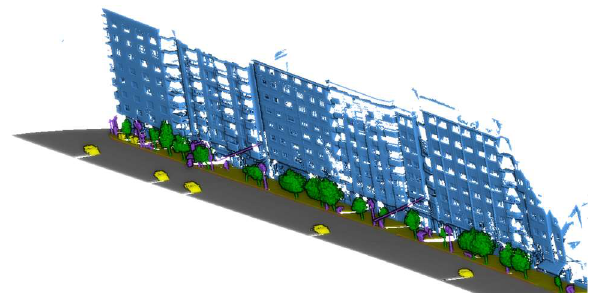
Figure 3: Time signal generated from consecutive scanlines of the point cloud.